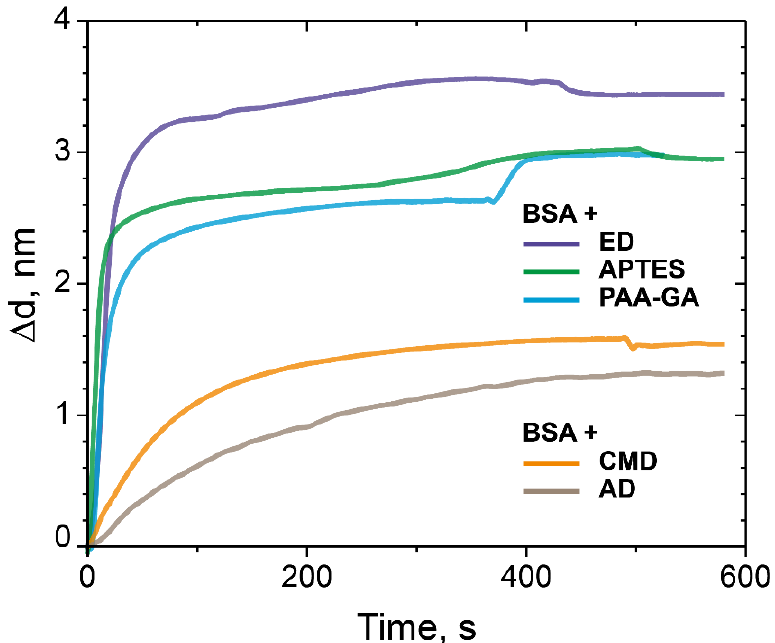
Figure 6. The change in the adlayer thickness upon the binding of BSA with the modified CMD, AD, ED-treated PC surface, and as controls—the PC surface treated with APTES and the PC surface modified with PAA and GA.